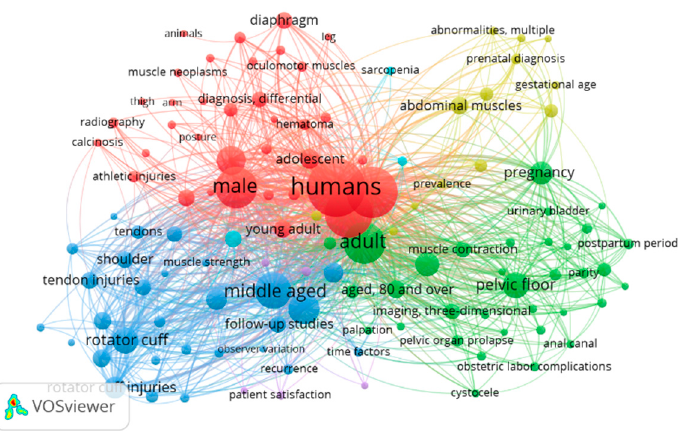
Figure 7. Visualization of keywords for ultrasound examination and skeletal muscle.